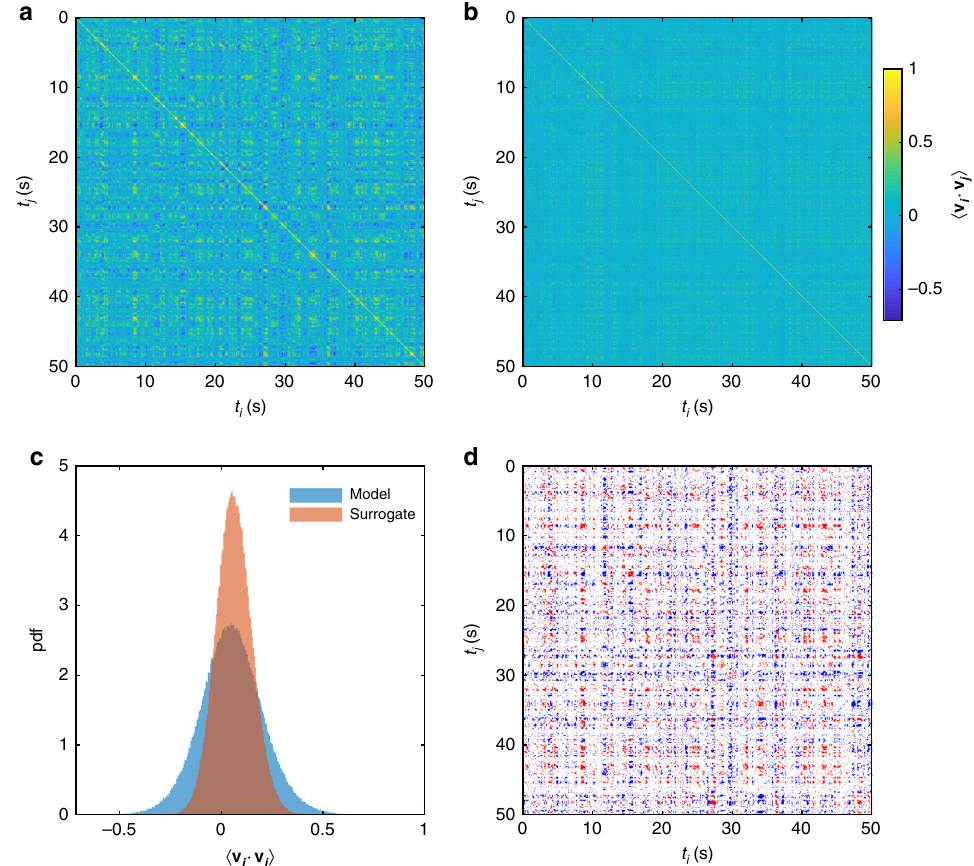
Fig. 5 Recurring fl ow patterns. a Recurrences between the mean alignment of velocity fi elds v i and v j at times t i and t j , respectively, in the model wave dynamics for c = 0.6, τ = 1 ms. b Recurrences for one instance of an amplitude-adjusted Fourier surrogate time series derived from the simulation used in a . c Histograms of recurrence values for the model (blue) and one surrogate (red). d Recurrence points where the model recurrence alignment was greater than (red) or less than (blue) all 100 surrogates. Red points correspond to fl ows aligned in the same direction, whereas all blue points correspond to fl ows aligned in opposite